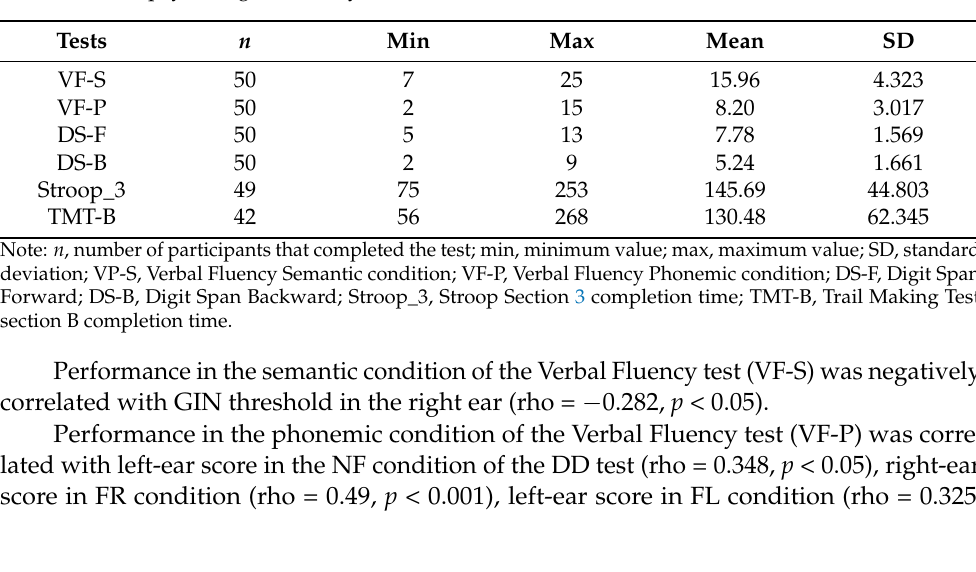
Table 2. Neuropsychological battery